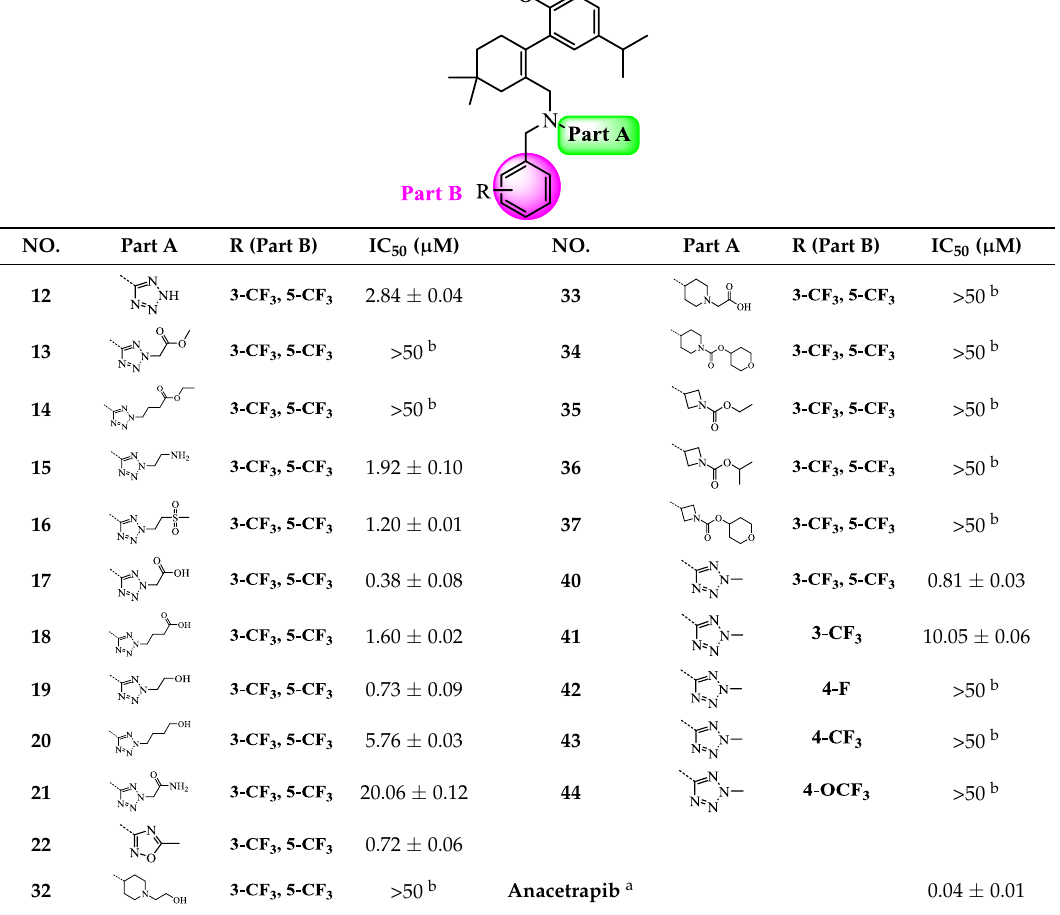
Table 1. Structures and activities of compounds 12 – 22 , 32 – 37 , 40 – 44 .